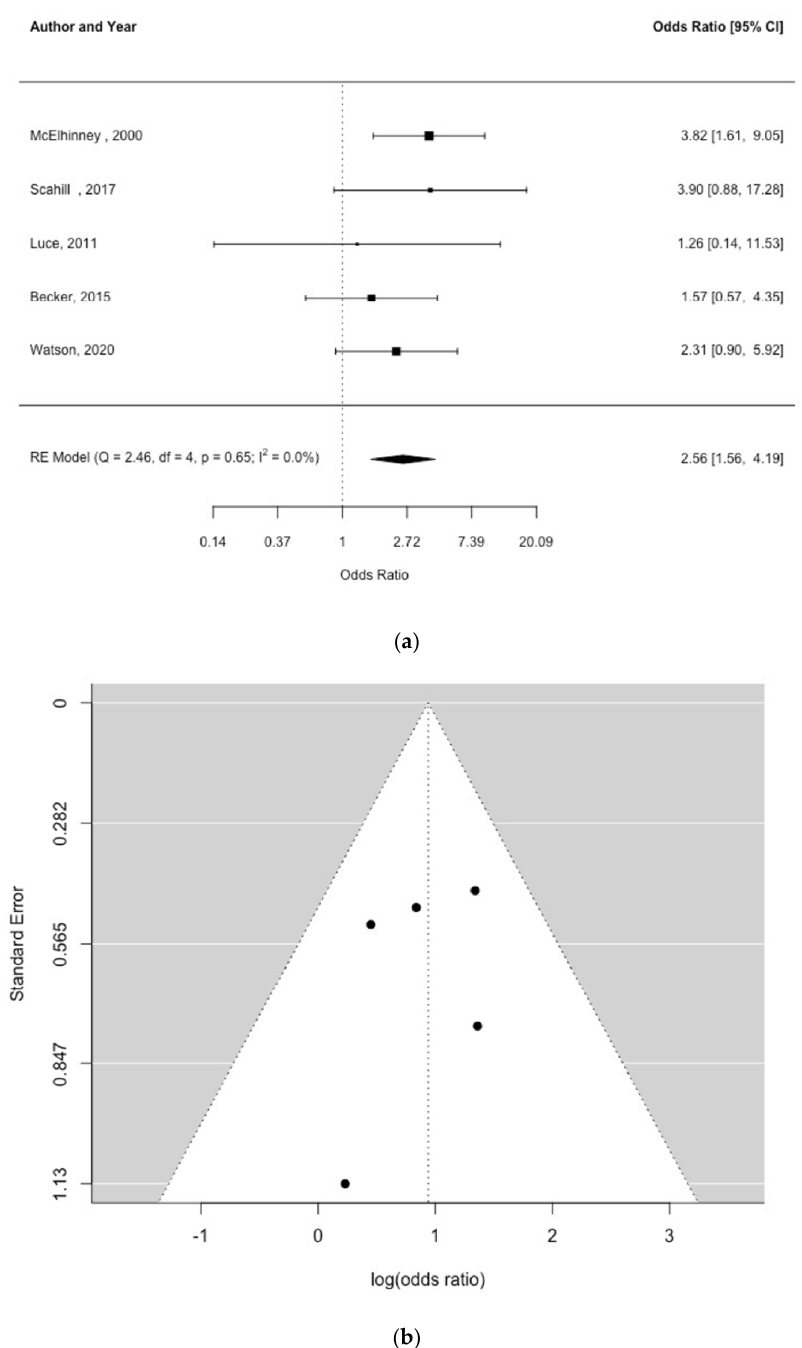
Figure 3. Forest plot ( a ) and funnel plot ( b ) of study effect estimates for hypoplastic left heart syndrome and NEC [shown as odds ratios and log (odds ratios), respectively] [5,23–26]. Egger’s test did not indicate funnel plot asymmetry [ p =